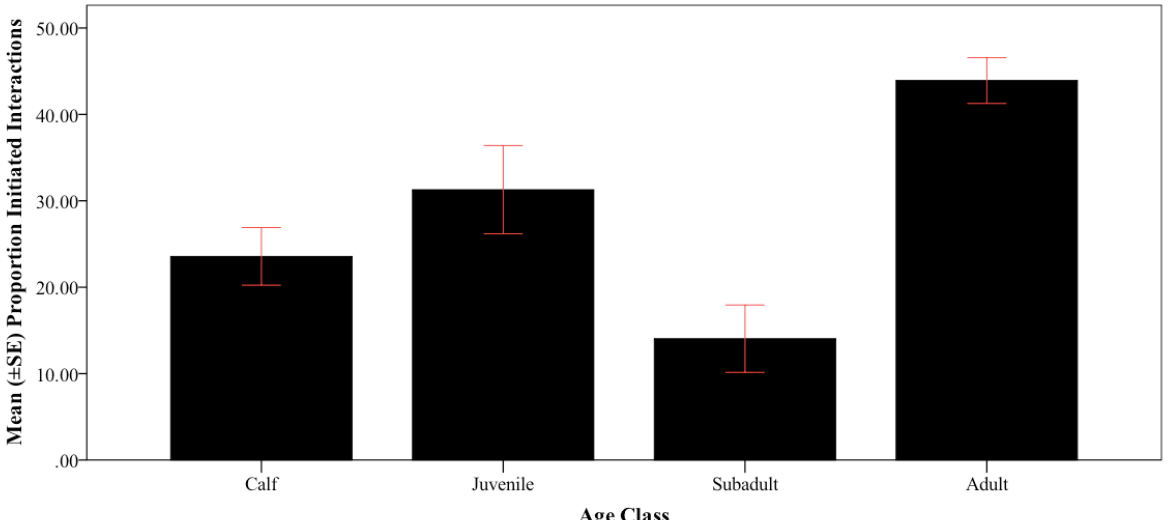
Figure 3. Mean (±1SE) proportion of the total number of social interactions initiated by each age class (calf, juvenile, subadult, and